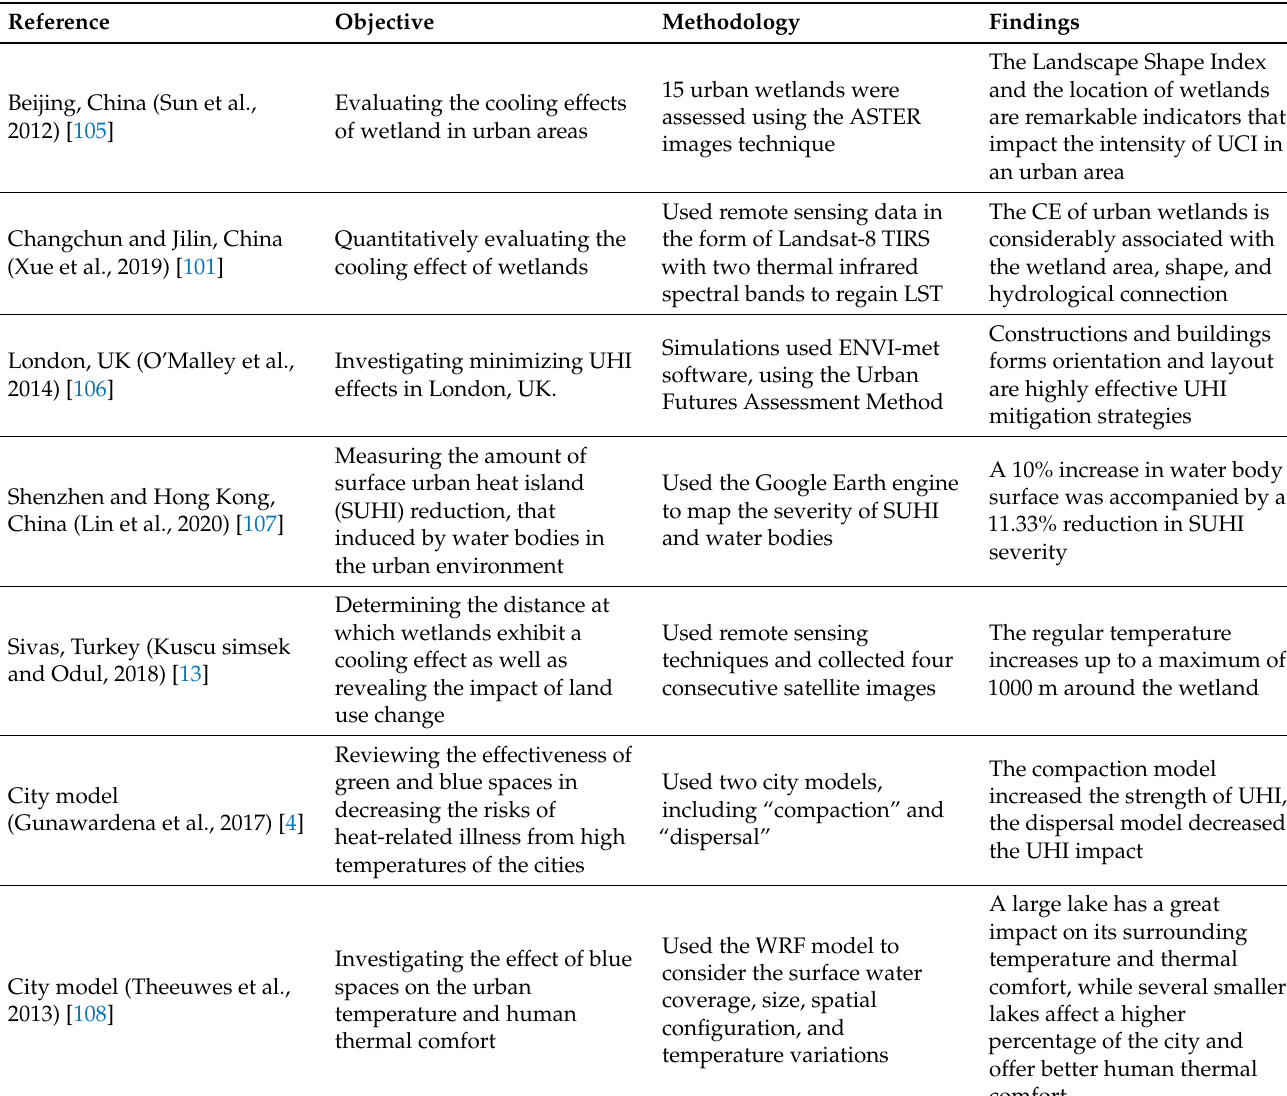
Table 3. Urban wetlands and urban heat